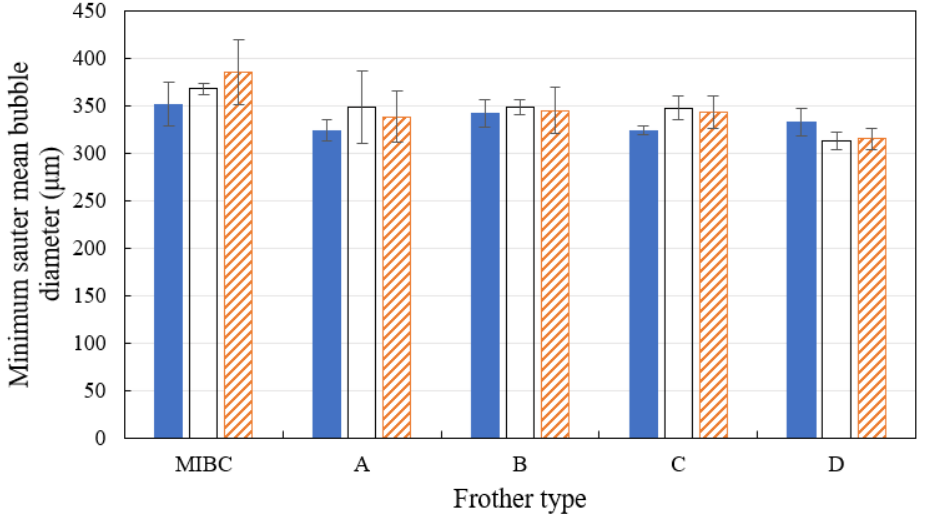
Figure 13. Minimum bubble size obtained at different frother types and water salinities conditions. The error bars represent the 95% confidence intervals of the mean values.